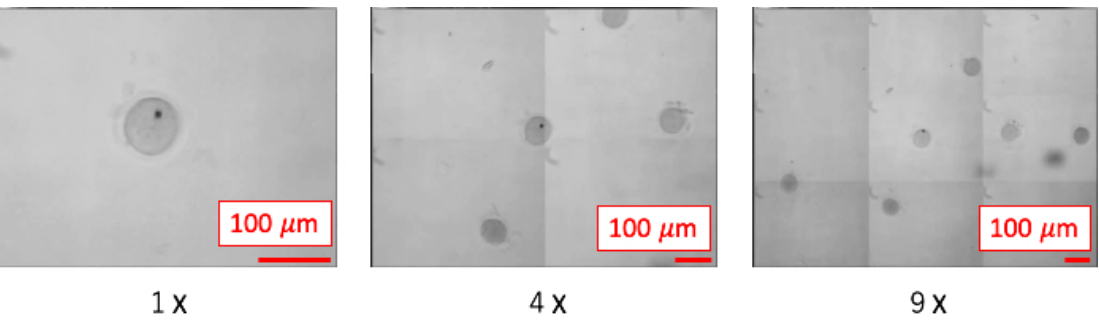
Figure 15. Images that were acquired when the visual field enlargement ratio was set to and ×